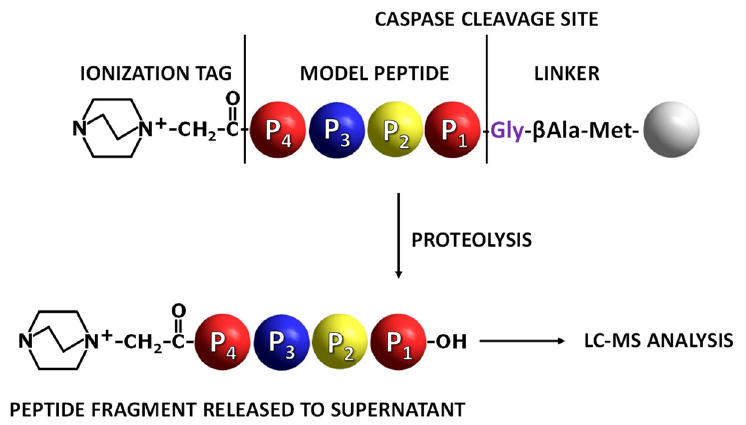
Figure 1. Application of fixed-charge tag peptidyl-resin in the analysis of caspase activity. Grey ball indicates TentaGel resin bead [19].